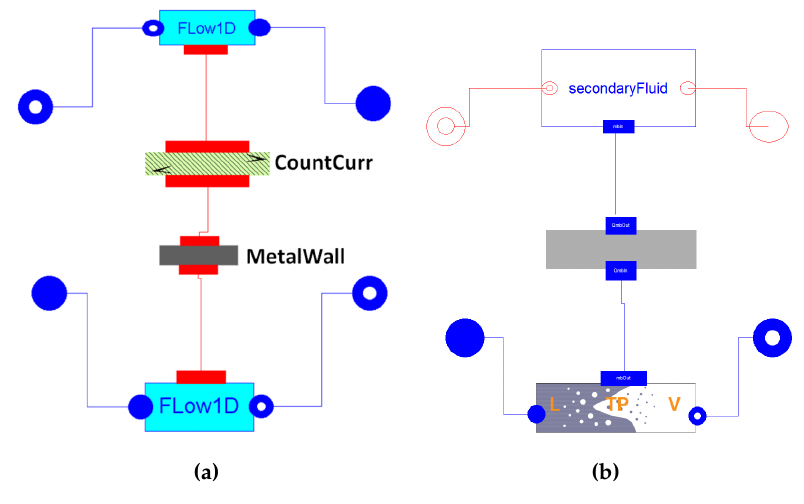
Figure 1. Representation of the finite volume ( a ) and the moving boundary ( b ) heat exchanger from the Dymola graphical user iterface